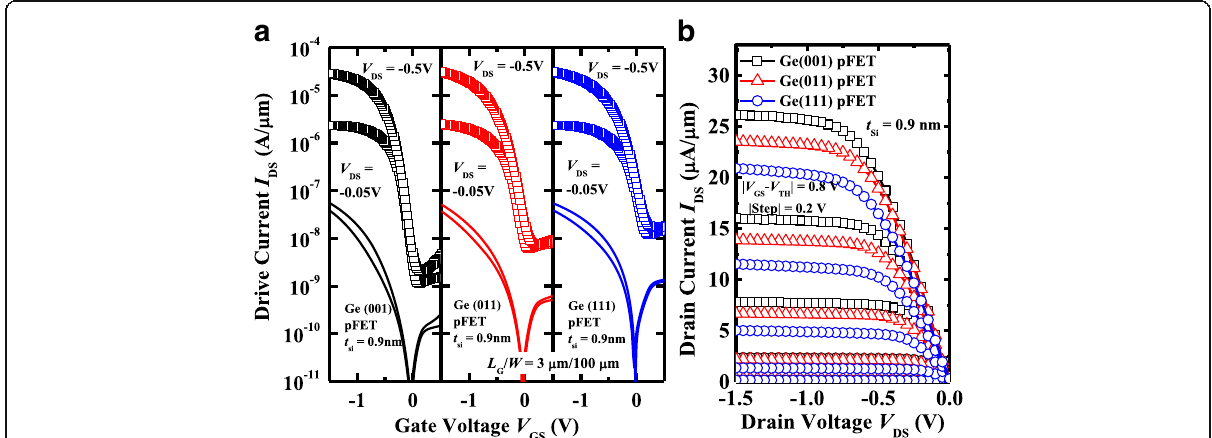
Fig. 3 a Measured I DS - V GS and I G - V GS curves of (001)-, (011)-, and (111)-oriented Ge pMOSFETs with 0.9nm t Si showing the excellent transfer characteristics. b I DS - V DS curves measured at different V GS - V TH for the